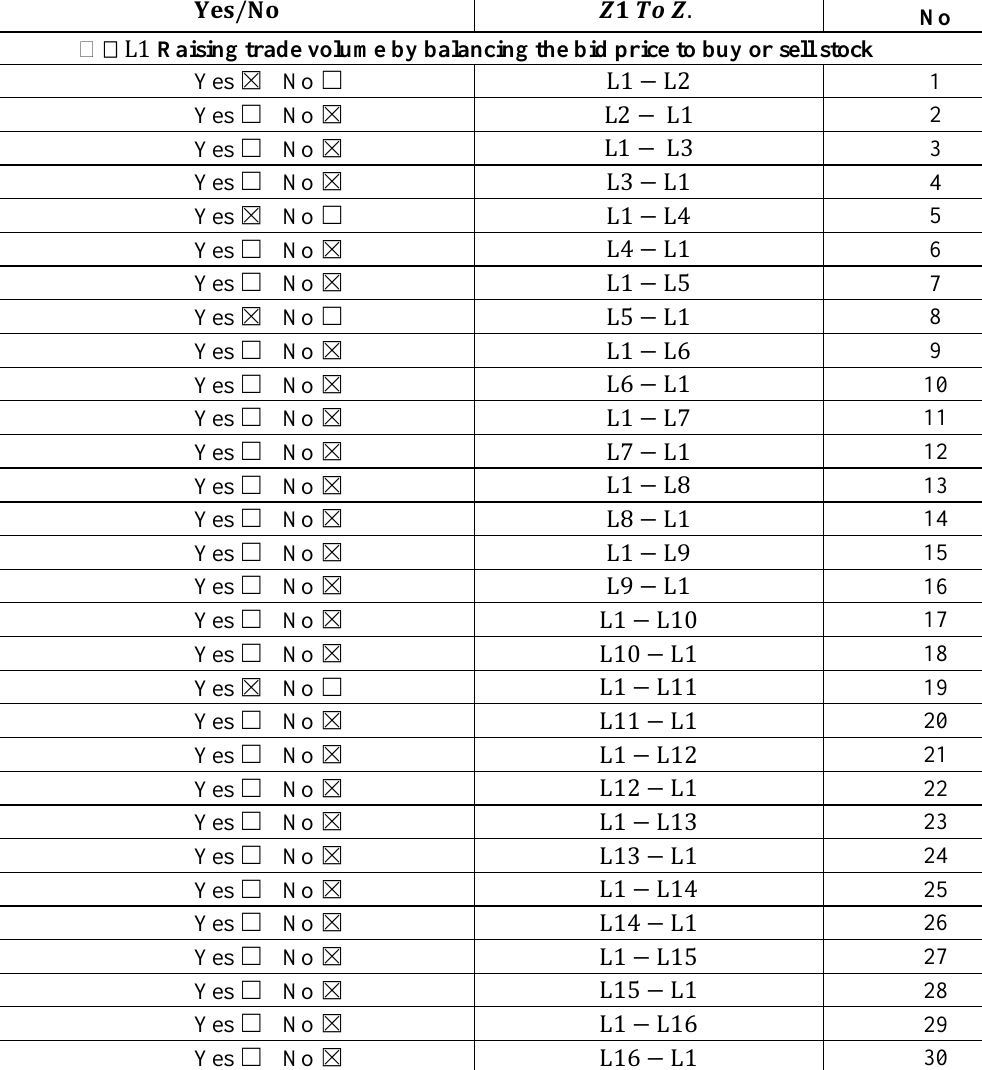
Table 8. Pair comparison between propositions based on matrix